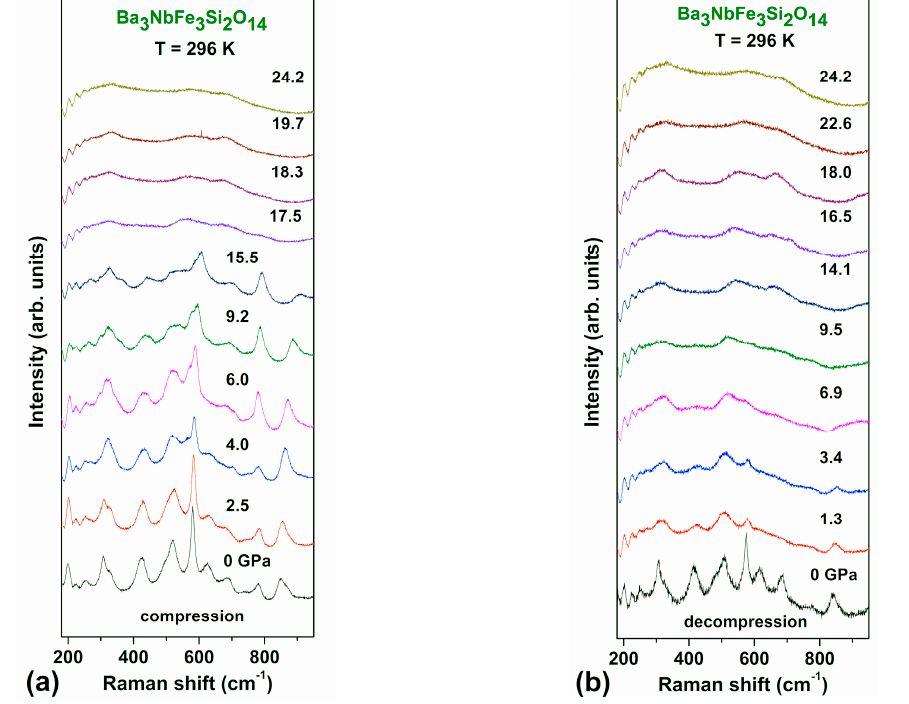
Figure 4. (Colour online) Raman spectra of Ba 3 NbFe 3 Si 2 O 14 at different pressures up to P = 24 GPa at compression ( a ) and decompression ( b ).